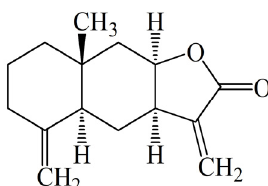
Figure 1. The chemical structure of isoalantolactone.